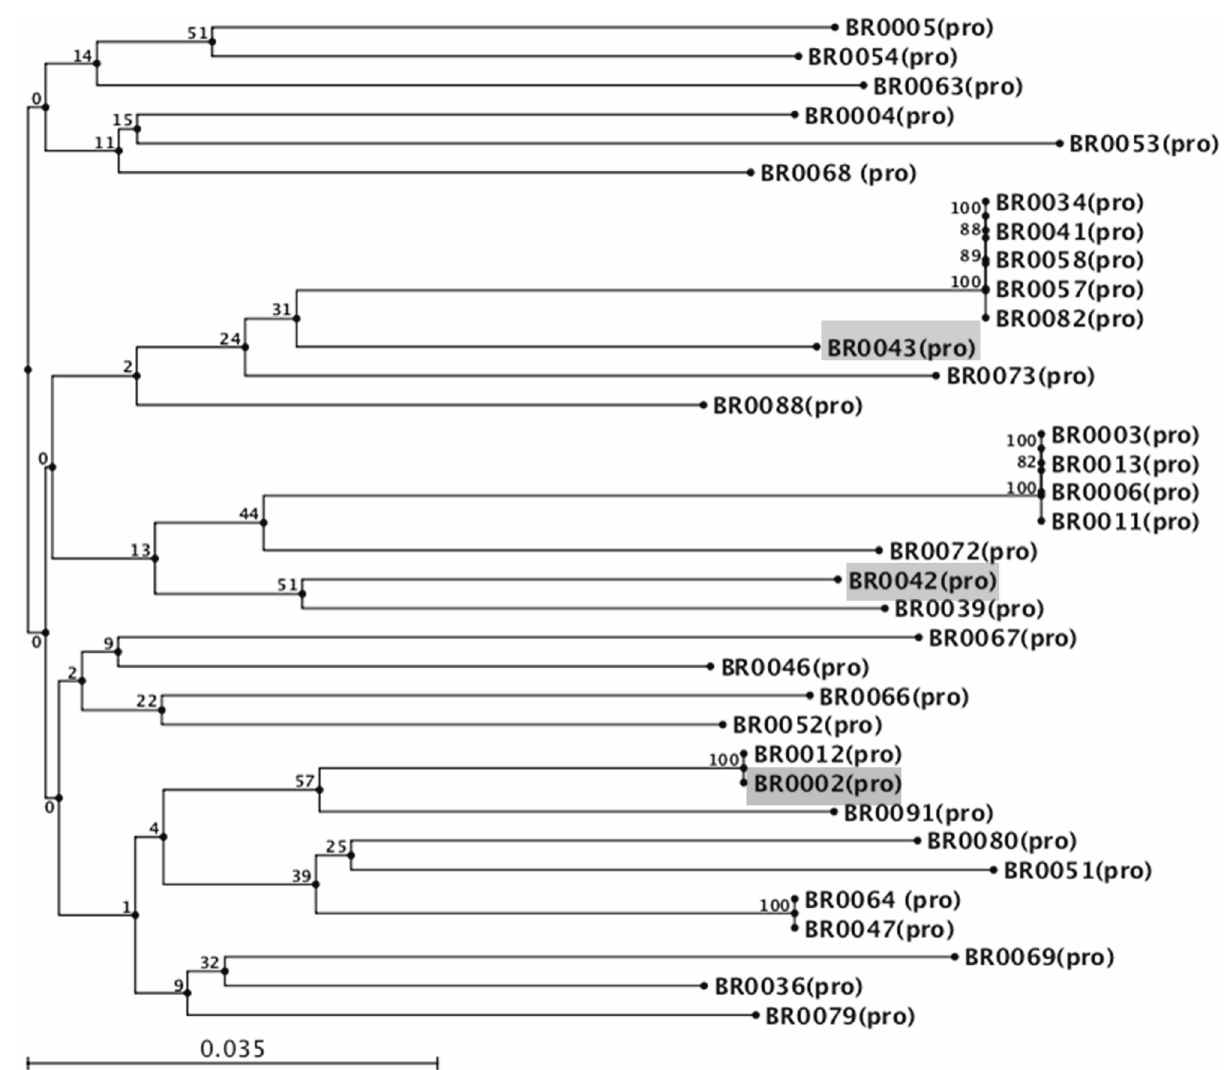
Figure 2. Neighbor-Joining phylogenetic analysis of the sdAb gene sequences isolated through phage display from naı¨ve llama library. 35 strong positive clones (from a total of 1000 clones) were screened for amino acid homology in the complementary determining regions (CDRs) of the sdAb gene. Out of them, 16 sequences could be efficiently cloned and expressed in E.coli expression system. The shaded clones depict the sdAb genes investigated in our study. Combodies, 26424 and 26434, were derived from BR0042 and BR0043 respectively; whereas the monomer, BR 2.3, was derived from BR0002. The tree topology with bootstrap values for 100 replicates is constructed using CLC Sequence Viewer 6.